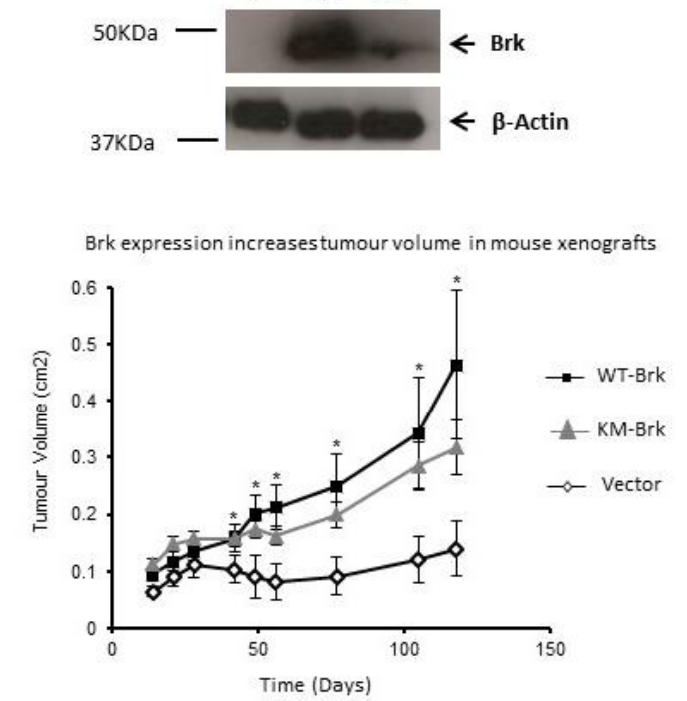
Figure 1. Brk promotes breast tumour xenograft growth ( A ) MDA-MB-157 cells were stably trans- fected with either the pRc/CMV vector (Vector), or a vector encoding wild-type (WT Brk) or kinase- inactive Brk (KM Brk), and the expression was confirmed by Western blotting with β -Actin expression as a loading control. ( B ) Cells were injected into the mammary fat pad of female CrTac:NCr-Fox-1(nu) athymic mice and tumour volume was calculated from the measurement of two perpendicular diameters over 118 days. Mean tumour volume (n = 10) +/ − SEM is plotted. * indicates p < 0.05 (student’s t -test, WT-Brk compared to the vector control).